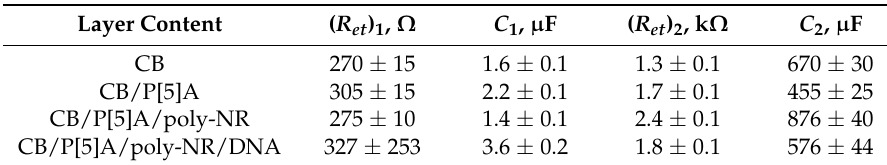
Table 1. The electrochemical impedance spectroscopy parameters obtained for stepwise assembling of the surface layer of DNA sensor. Measurement conditions are presented in legend to Figure 6. Average of six replicates.